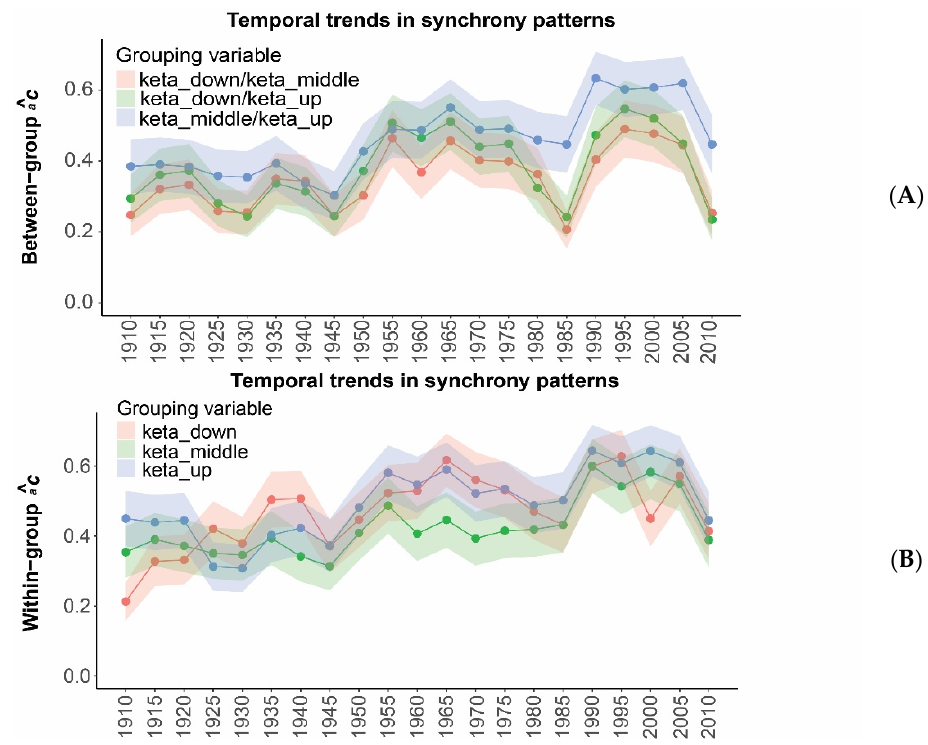
Figure 5. Synchrony estimates (âC) for tree ring width at ( A ) within-group and ( B ) between-group levels are calculated for the best model for 30-year moving intervals lagged by 5 years over the period 1900–2019. The x-axis shows the central year of the moving time interval. Grouping of chronologies is based on the position of study plots along a vertical gradient (KD—blue, KM—green and KU—red). Shadows are standard errors (SE).